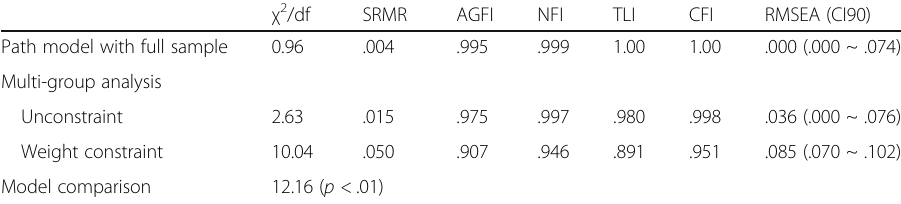
Table 3 Fit indexes of the model and the multi-group analysis χ 2 /df SRMR AGFI NFI TLI CFI RMSEA (CI90) Path model with full sample 0.96 .004 .995 .999 1.00 1.00 .000 (.000 ~ .074) Multi-group analysis Unconstraint 2.63 .015 .975 .997 .980 .998 .036 (.000 ~ .076) Weight constraint 10.04 .050 .907 .946 .891 .951 .085 (.070 ~ .102) Model comparison 12.16 ( p <